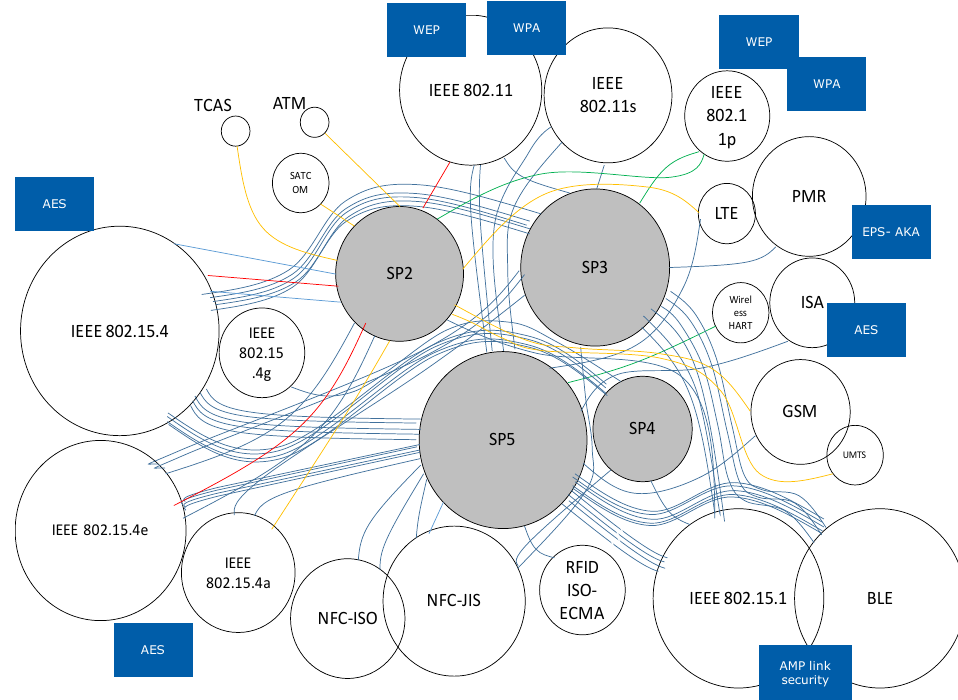
Figure 4. Wireless standards used in DEWI with some security features. SP2-Aeronautics, SP3 Automotive, SP4 Railway, SP5